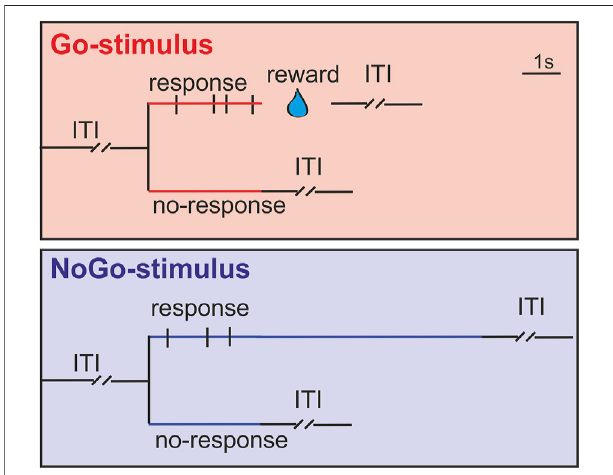
FIGURE 2 | Schematic drawing of the training paradigm. Stimuli were presentedtoeacheyeinpseudorandomlyinterleavedtrialswith15 sinter-trial intervals (ITI). Animals were trained to either respond to Go-stimuli (red line) or withhold responses to NoGo-stimuli (blue line) during a 3 s response period after the stimulus onset. Correct responses in Go-trials were rewarded with water at the end of response period and the stimuli were switched off during the reward time. Correct responses (no jaw movements) to NoGo- stimuli were not rewarded, whereas jaw movements during the 3 s response period prolonged stimulus presentation time from 3 s to 9 s. Black vertical bars during the 3 s response period indicate jaw movements of animals